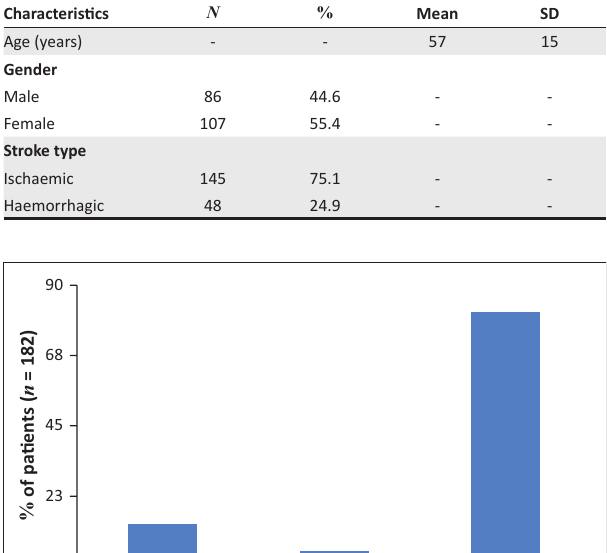
TABLE 1: Demographics of patients presenting with stroke ( N = 193). Characteristics